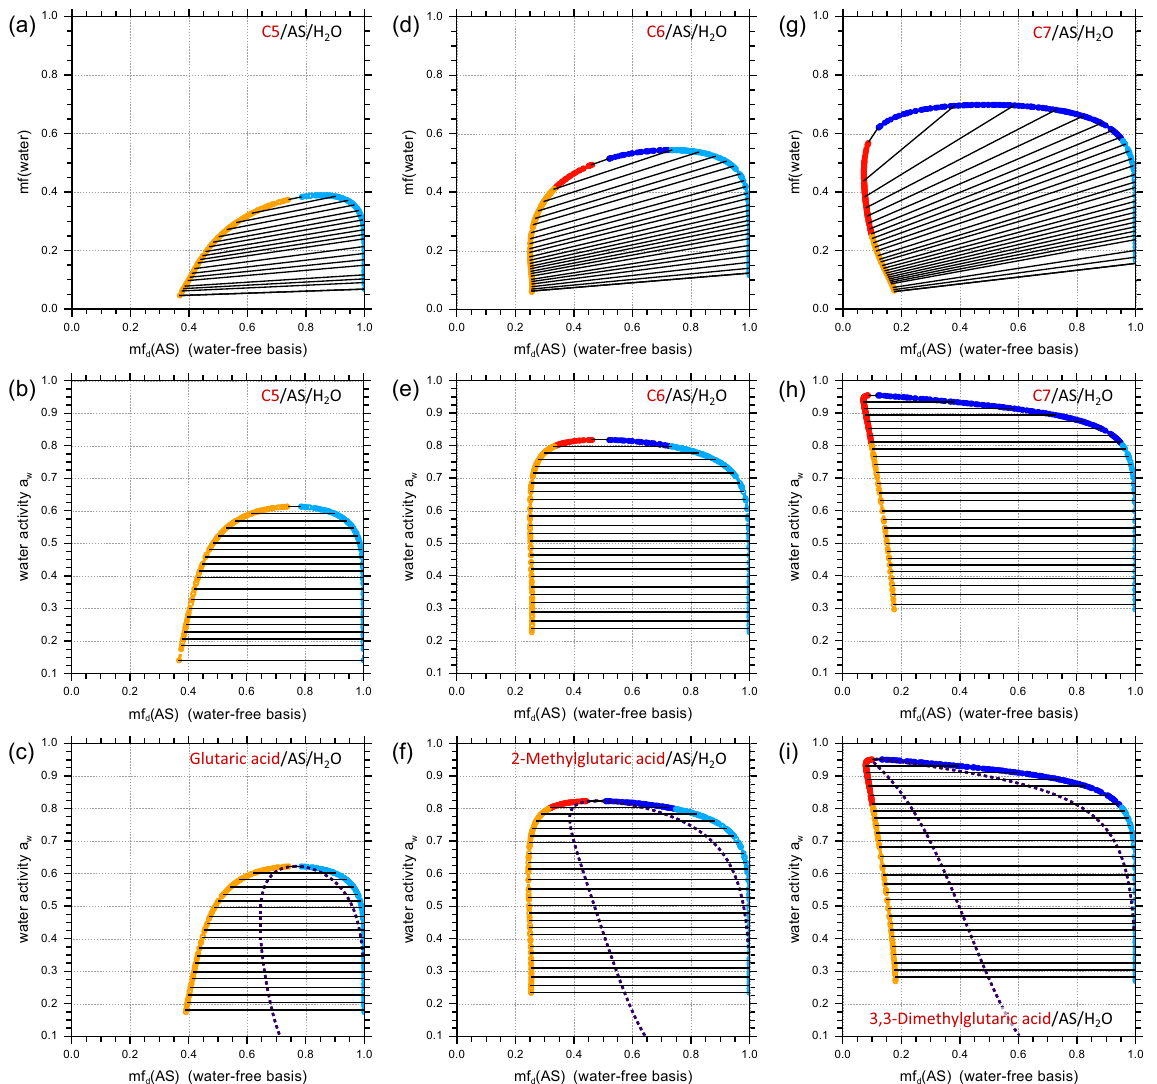
Fig. 8. Predicted phase diagrams of C5/AS/H 2 O (left), C6/AS/H 2 O (center), and C7/AS/H 2 O (right) computed at 298K using AIOMFAC. Top panels: liquid-liquid coexistence curve (colored) and tie-lines (black) given as water-free “dry” mass fraction of AS, mf d (AS) vs. mass fraction of water, mf(water). Each tie-line connects the two coexisting equilibrium phase compositions. Center panels: same as top panels but mf(water) replaced by water activity (=RH when liquid and gas phase are in equilibrium). Bottom panels: same as center panels but for ternary systems. Dotted lines: spinodal curves. Coexistence curve colors: red and blue branches indicate aqueous organic-rich phase and aqueous AS-rich phase, respectively. Orange and light blue indicate supersaturation with respect to crystalline AS. The calculated coexistence curves are discontinued at low a w due to numerical stability issues at very high supersaturation of AS (AS would crystallize before reaching those